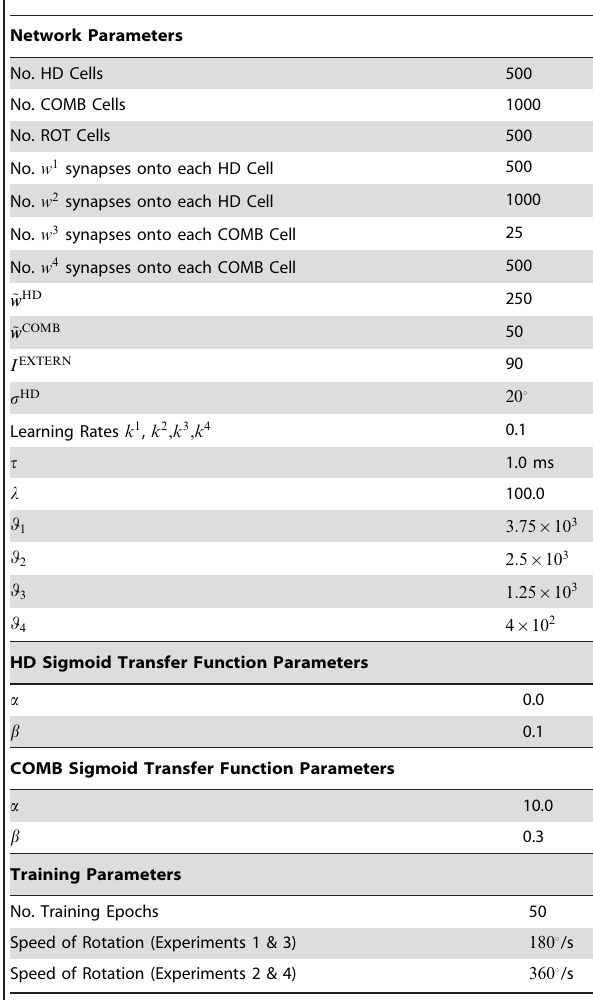
Table 1. Simulation parameter values.